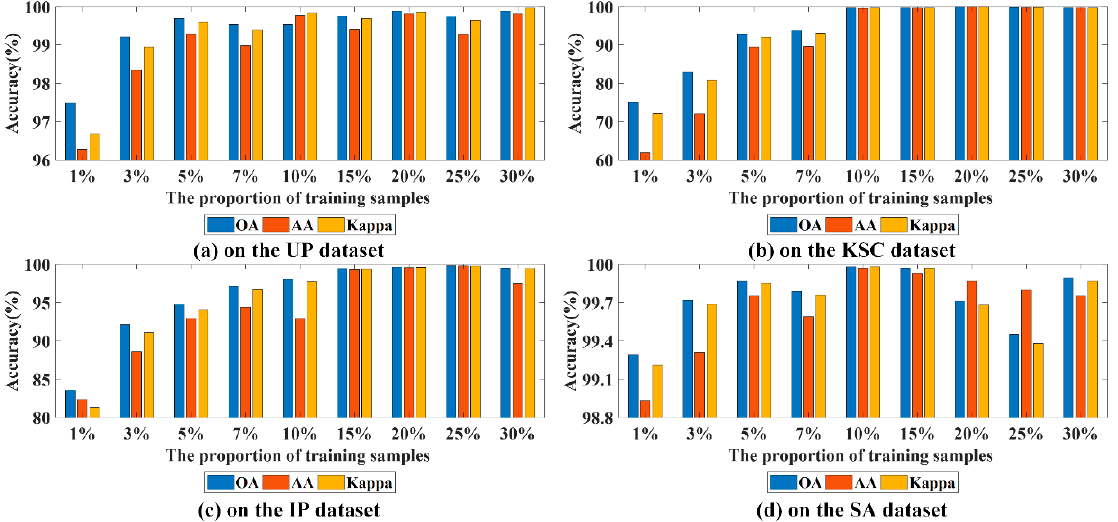
Figure 6. Three evaluation indexes for diverse training percentages on four experimental datasets.